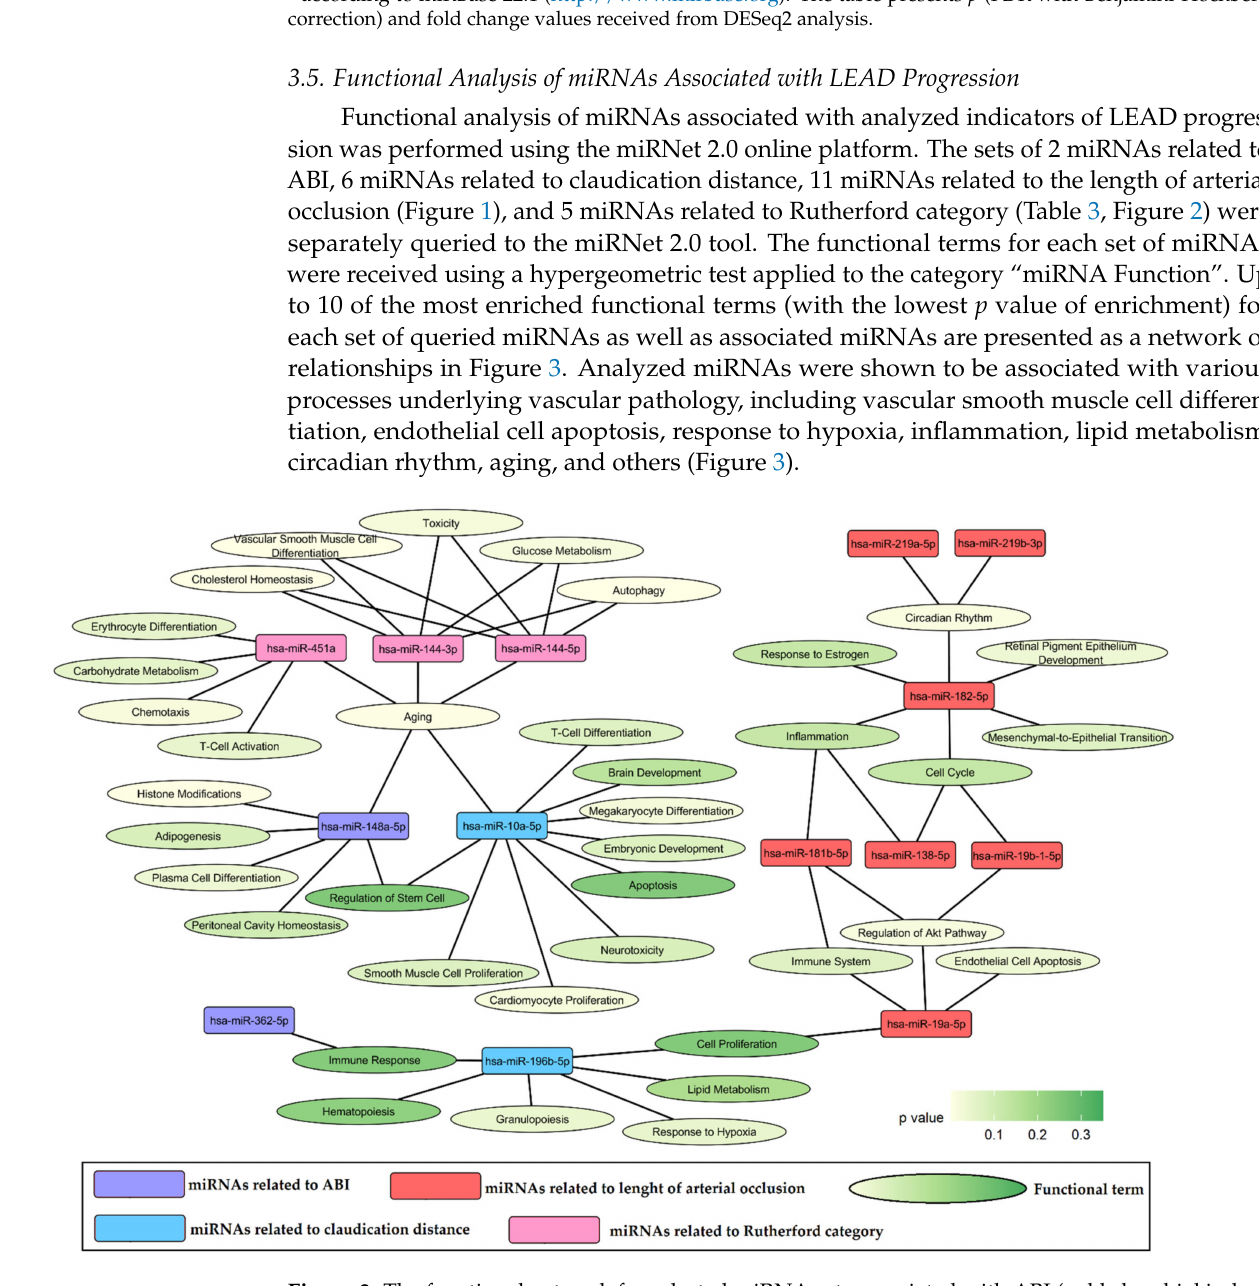
Figure 3. The functional network for selected miRNA sets associated with ABI (ankle brachial index), claudication distance, length of arterial occlusion and Rutherford category in studied group